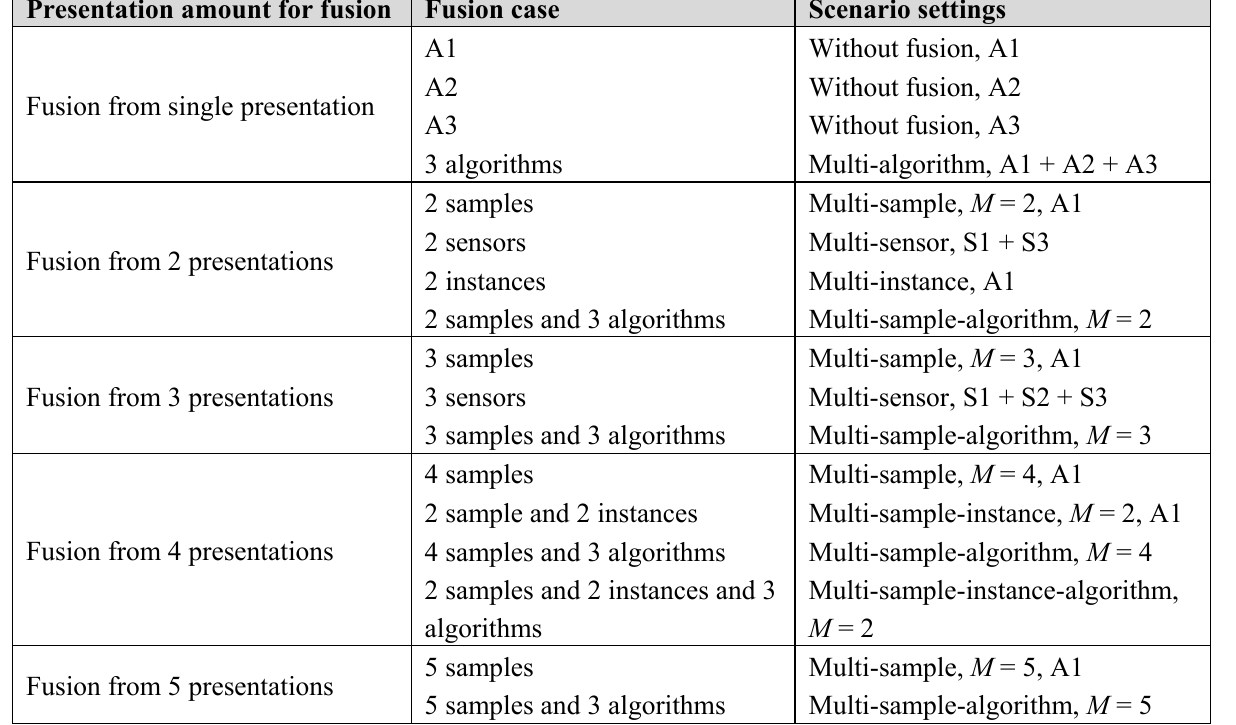
Table 12. Fusion scenario settings for fusion cases by “efficiency per